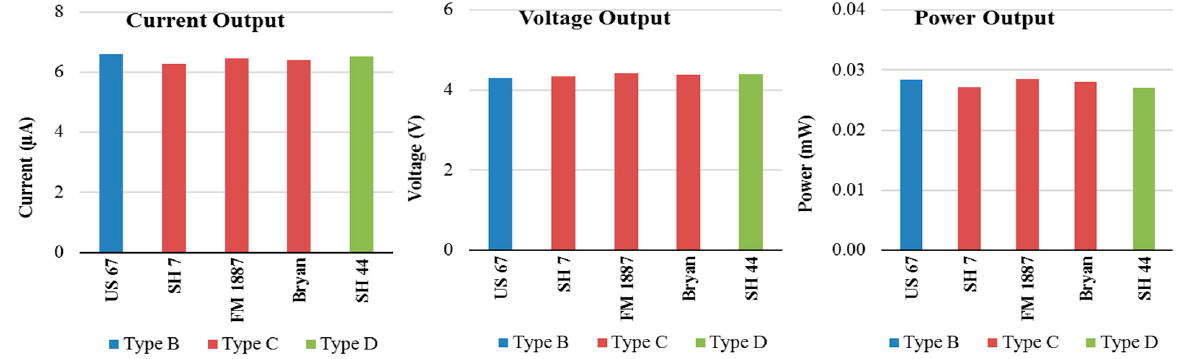
Figure 6. HWTT-HiSEC Energy Generation—HMA Variation (1 Hz and 20 °C).